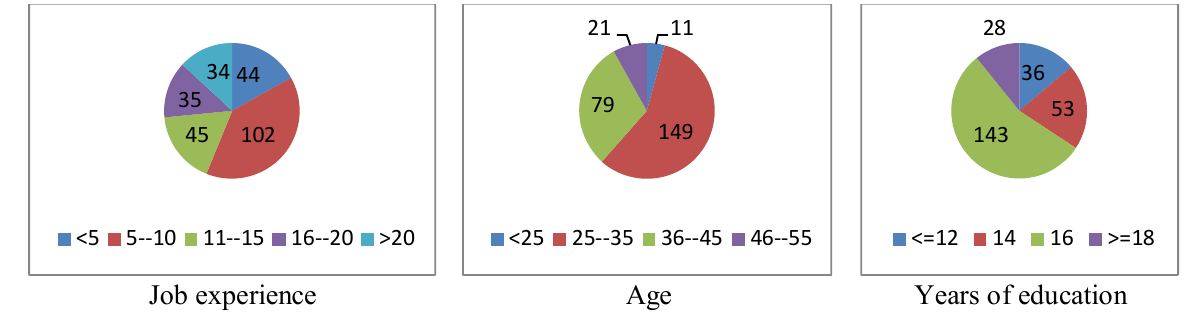
Fig. 1. Personal characteristics of the participants